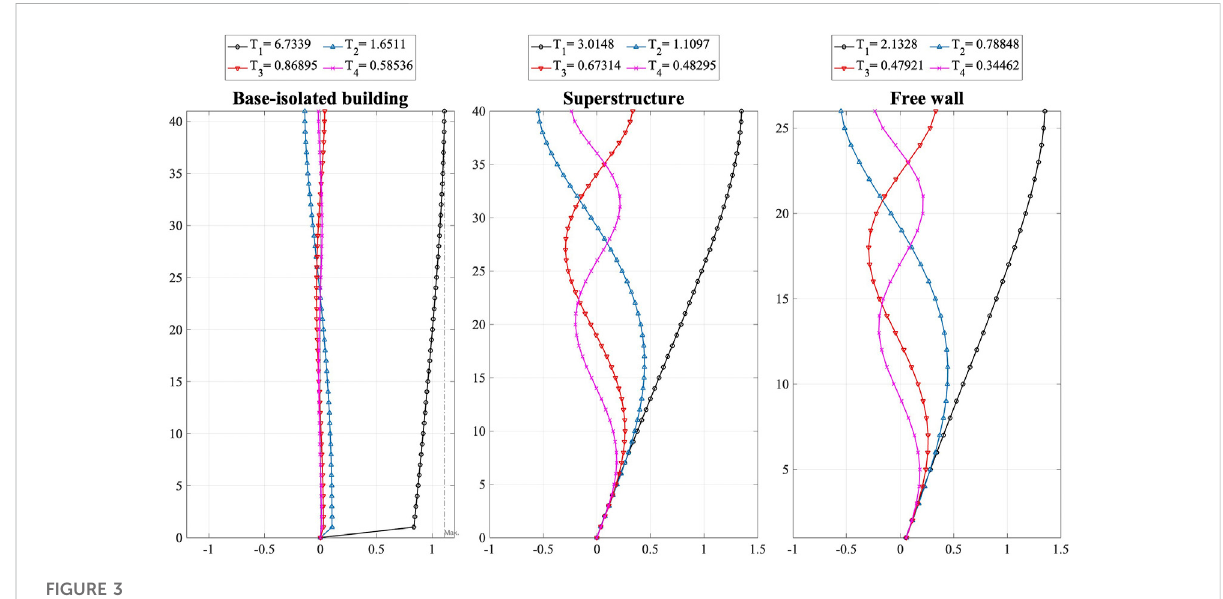
FIGURE 3 Modal analyses of each building.